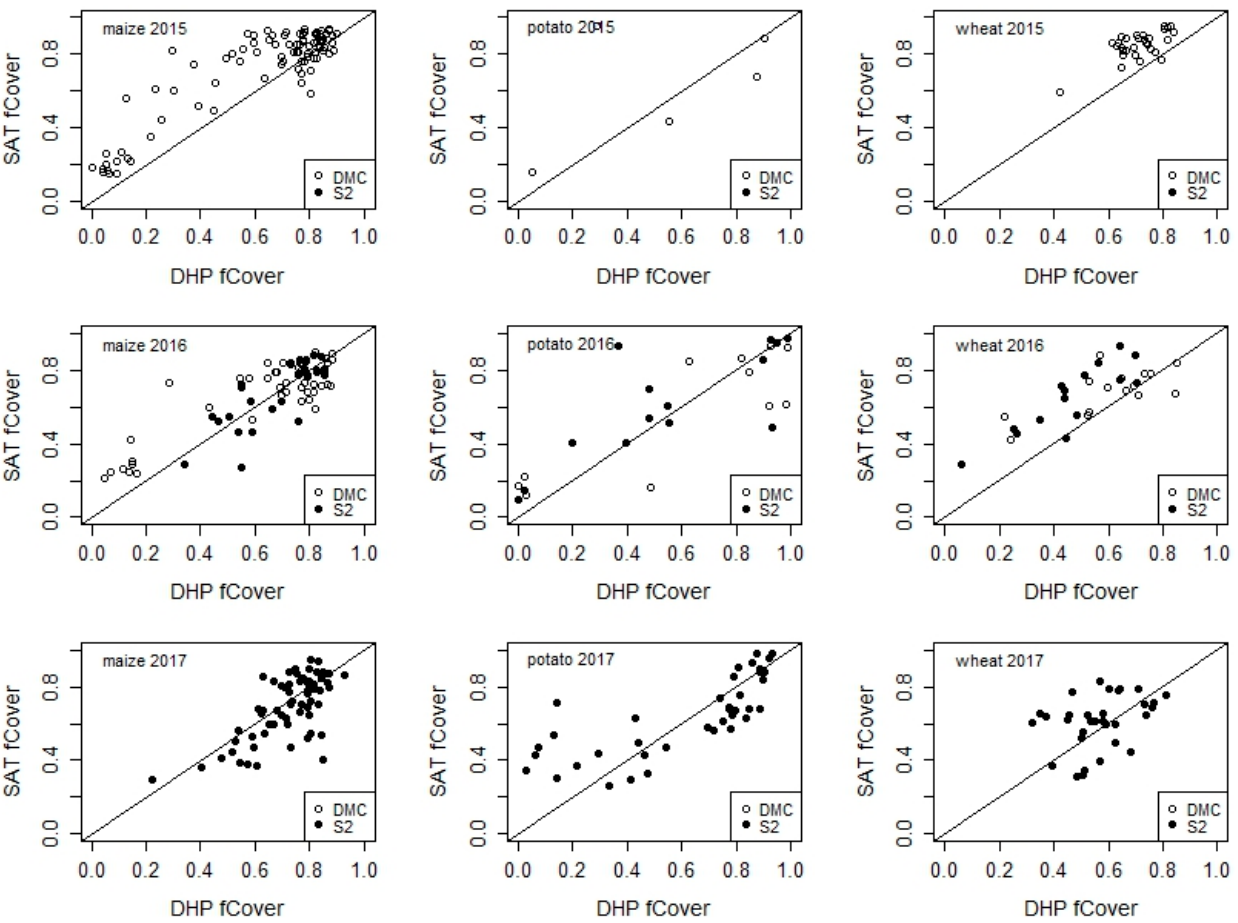
Figure 12. Relationship between Sentinel-2-, DMC-, and DHP-derived fCover during three years of measurement in arable fields. Each dot represents the median value for a field. The straight line represents the 1:1 line.